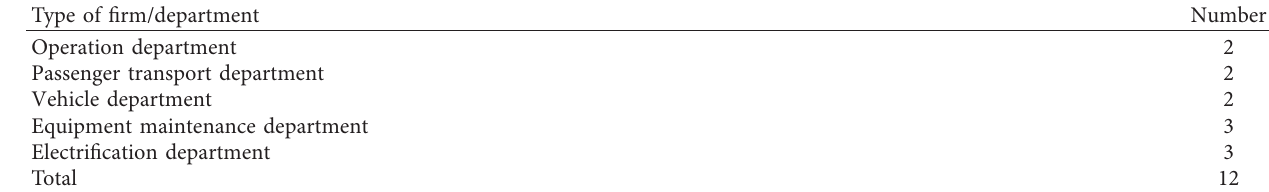
Table 1: List of the panel of experts for the interview